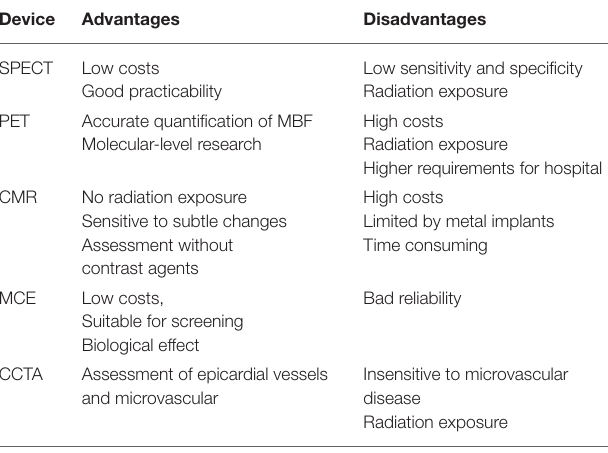
TABLE 1 | Comparison and progress of various equipment for the diagnosis of myocardial ischemia (87). Device